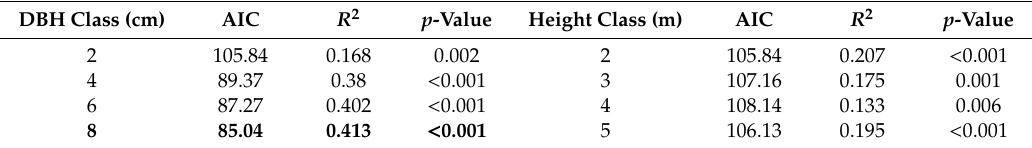
Table 2. General linear relationship between aboveground C storage and stand structural (tree diameter at breast height (DBH) and height) diversity of di ff erent classes across the plots. The bold discrete classes were